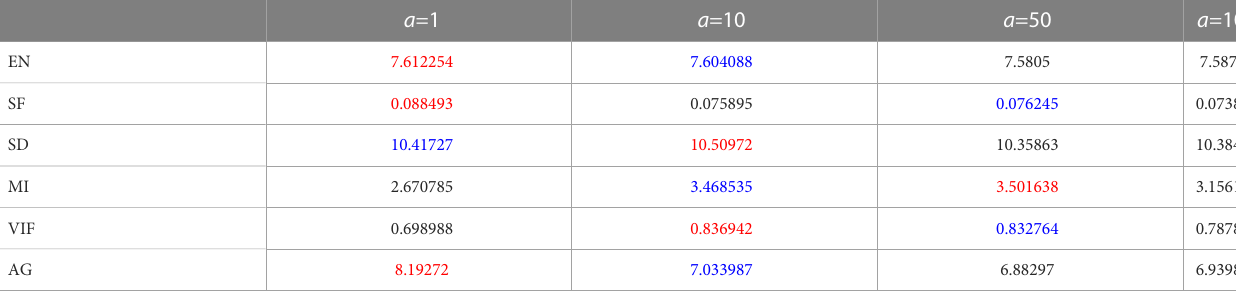
The red word represents the best, and the blue word represents the second